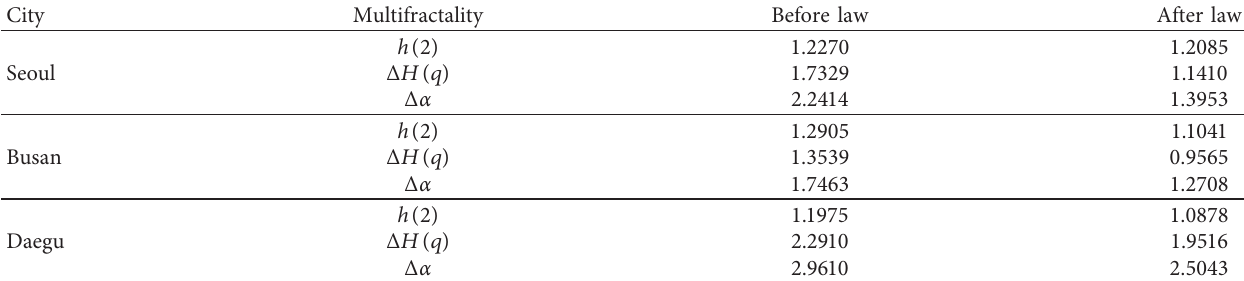
Table 4: Multifractality for PM